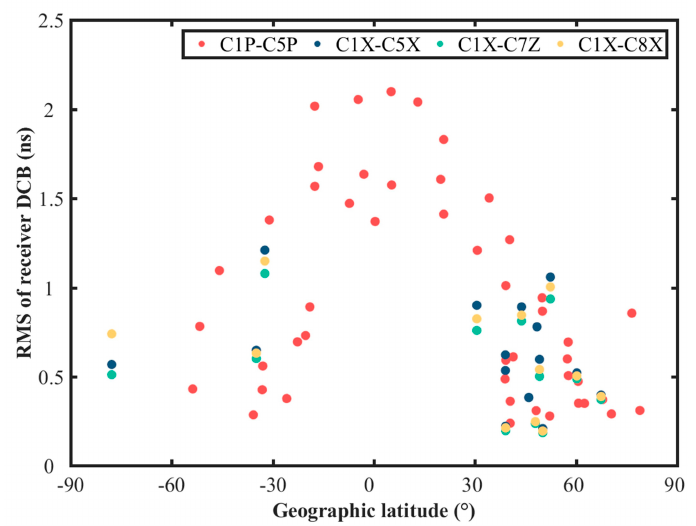
Figure 9. RMS error of the estimated BDS-3 receiver DCBs with respect to the products provided by CAS during the period of DOY 60–89 in 2021.